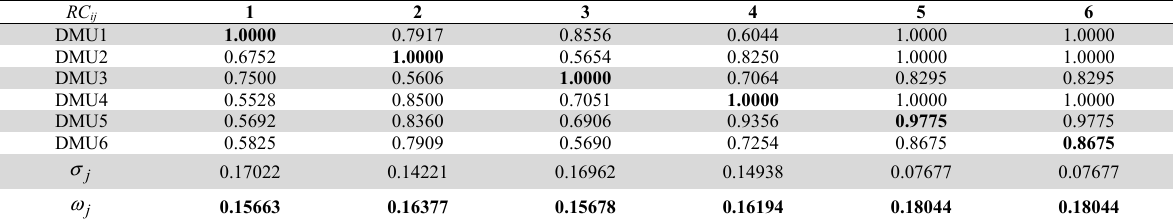
The combined CEMs for six nursing homes RC ij